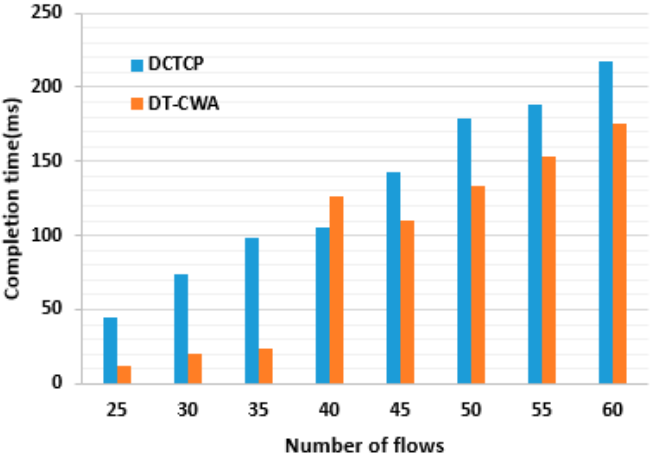
Figure 7. Comparison of average query completion time.